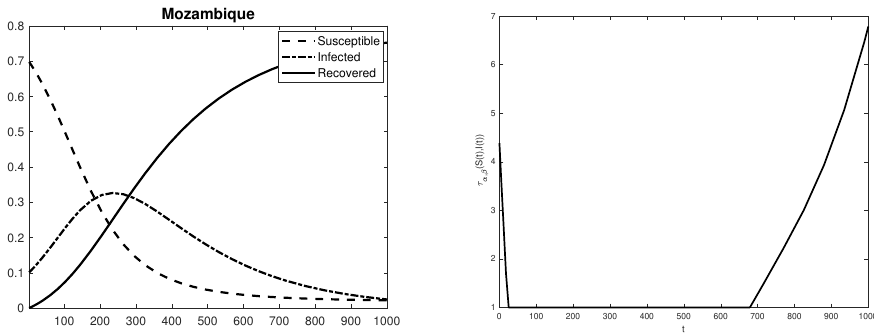
Figure 7. Solution to the SIR model (1), with initial value given by the vector (4), for Mozambique ( left ) and corresponding pattern of τ α , β ( S ( t ) , I ( t )) ( right ).